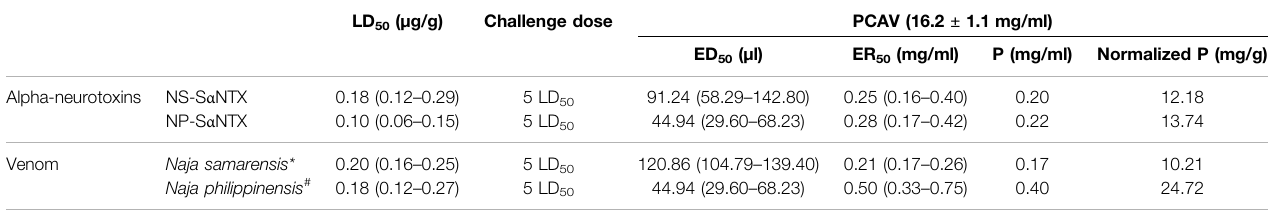
TABLE 4 | Neutralization of the alpha-neurotoxins and venoms of Philippine cobras, Naja samarensis and Naja philippinensis by antivenom. LD 50 ( μ g/g) Challenge